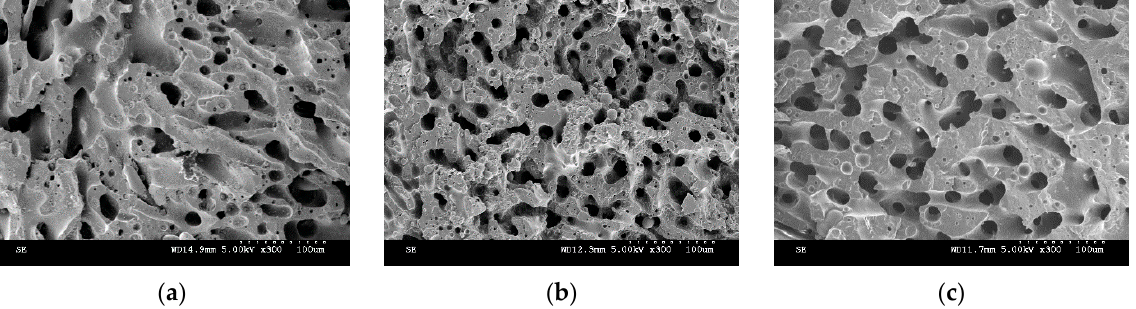
Figure 5. Morphology of the selected PP/PS/MWCNTs composites with 0.3 wt.% of MWCNTs for ( a ) fast ‐ cooling treatment; ( b ) isothermal treatment; and ( c ) slow ‐ cooling treatment.